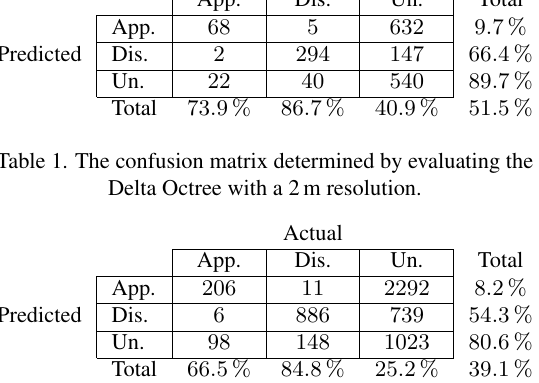
Table 2. The confusion matrix determined by evaluating the Delta Octree with a 1m